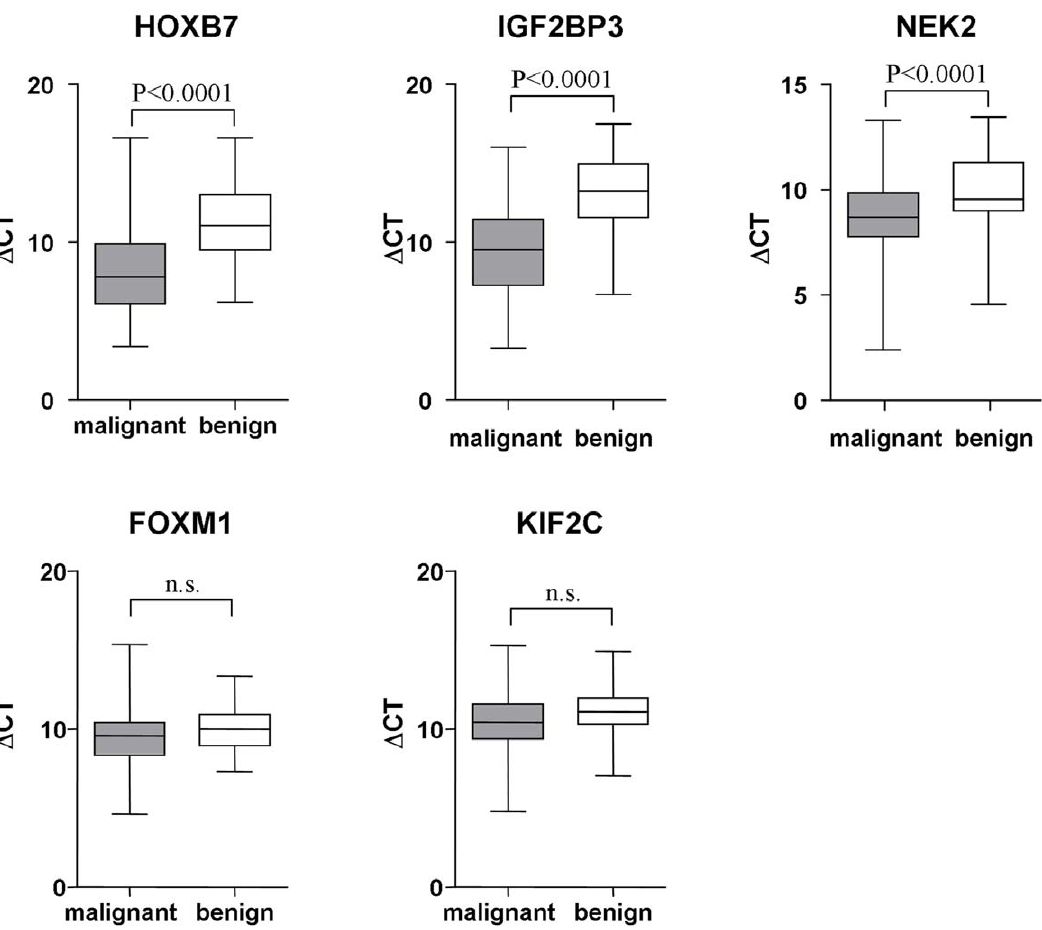
Figure 2. Differences in threshold cycle numbers between target genes (HOXB7, IGF2BP3, NEK2, FOXM1, KIF2C) and the house- keeping gene GAPDH ( D CT) between patients with malignant (grey boxes) and benign (white boxes) biliary strictures. Results are shown as Box plots with (10-, 25-, 50-, 75-, and 90-percentiles).